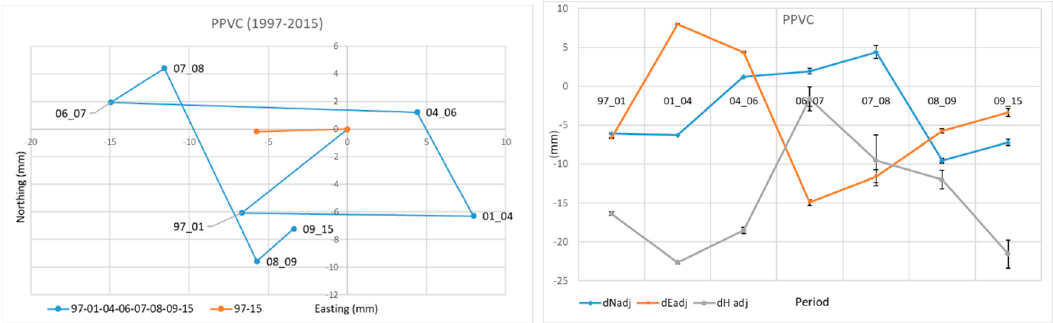
Figure 8. Point PPVC. Movements on all sides, small values of movements; Movement causes–position in the framework.